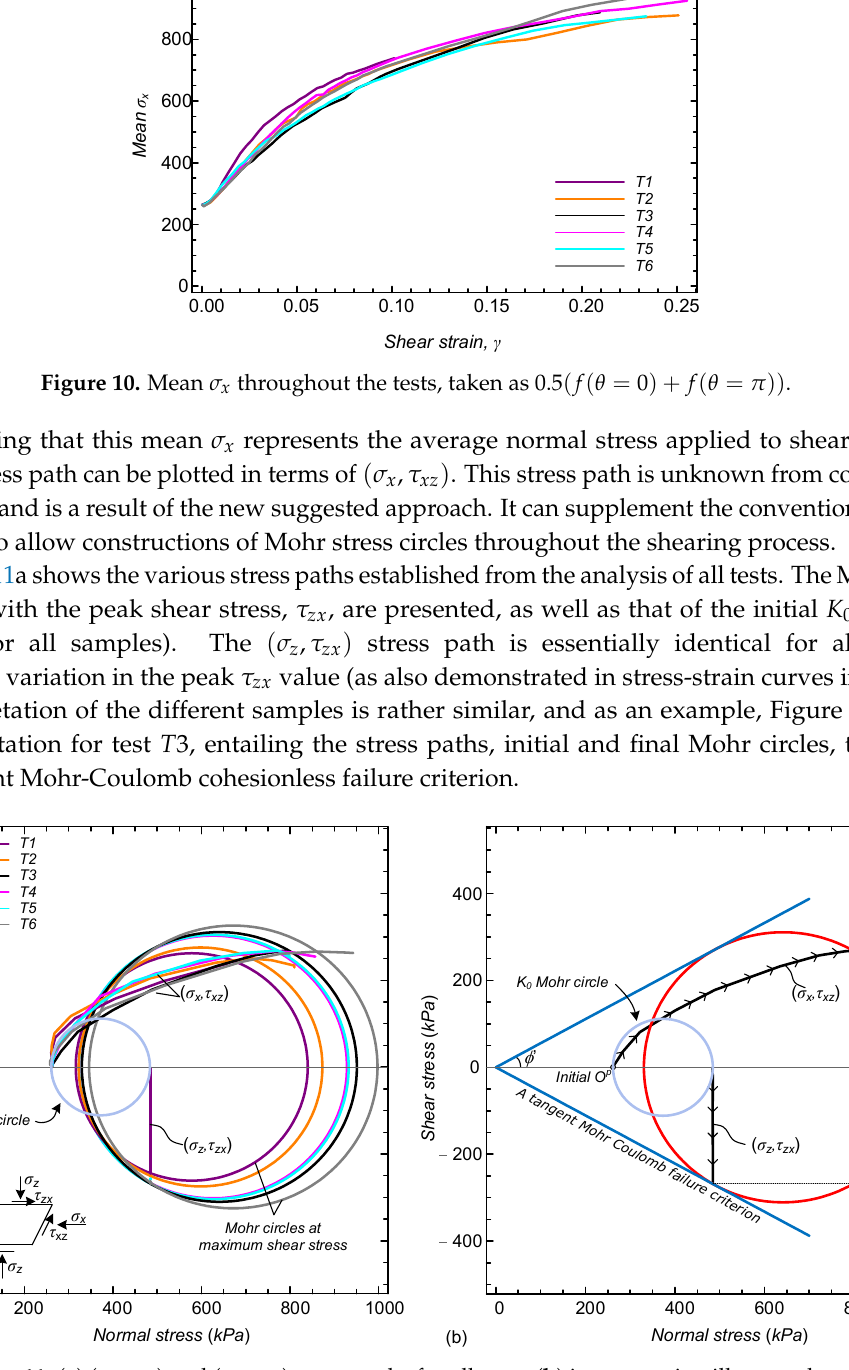
Figure 11. ( a ) ( σ z , τ zx ) and ( σ x , τ xz ) stress paths for all tests; ( b ) interpretation illustrated on